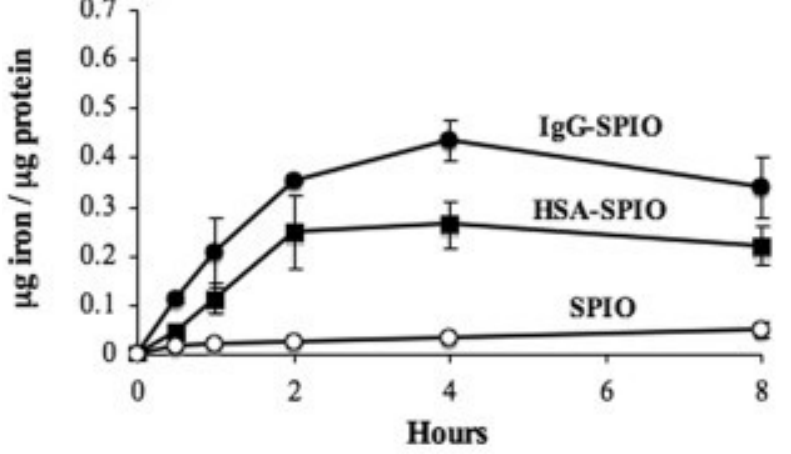
Figure 1. Iron oxide nanoparticle uptake by monocytes and macrophages with different ligands; IgG, human serum albumin and no ligand. SPIO = superparamagnetic iron oxide, IgG = immunoglobulin G, HSA = human serum albumin [45].